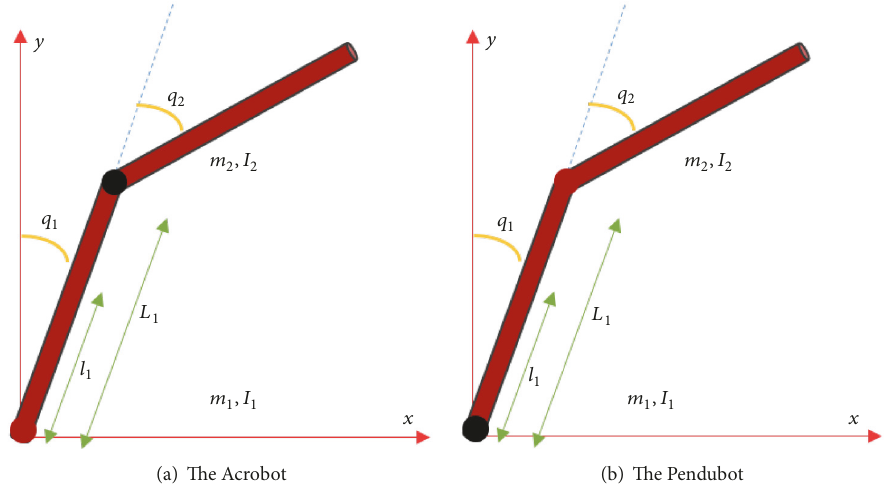
Figure 1: The 2-link planar